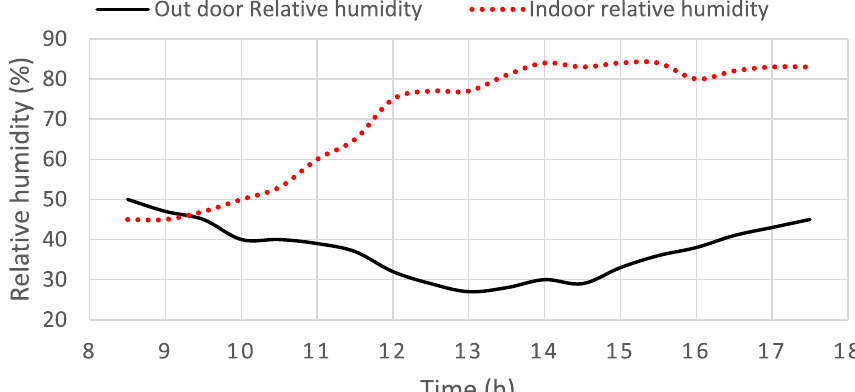
Fig. 7 Variation of outdoor and indoor relative humidity with time for day